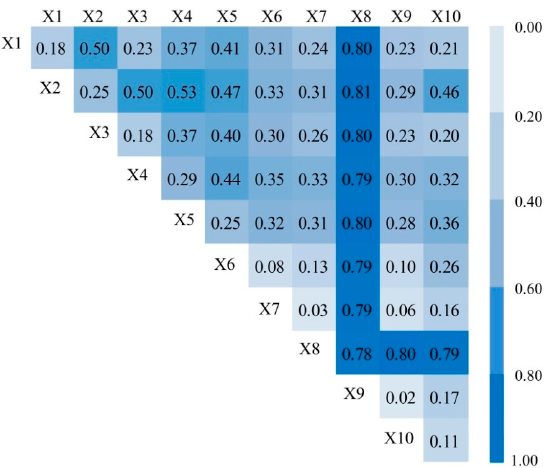
Figure 5. Interaction detection of factors.